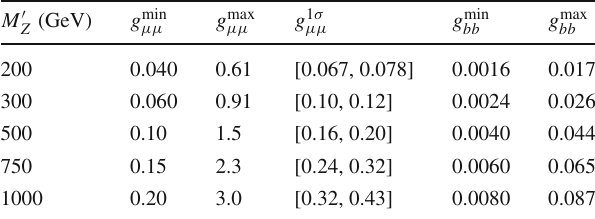
Table1 Intervalsforthecouplings g μμ and g bb consistentwithexplain- ing the b → s (cid:2)(cid:2) anomalies, and not excluded at 99% CL by the CKM [53] and trident [50] constraints. We also show the 1 σ confidence inter- val for the coupling g μμ obtained from the likelihood combining the above mentioned